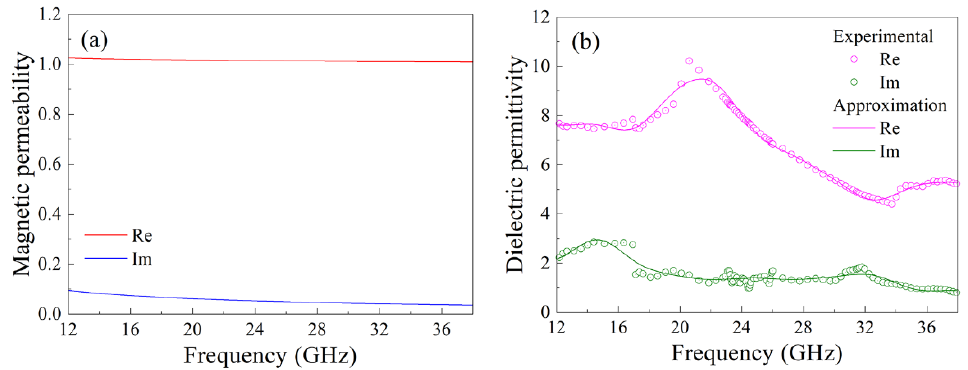
Figure 6. Frequency dependences of magnetic permeability ( a ) and dielectric permittivity ( b ) for the composite with 15% flakes.